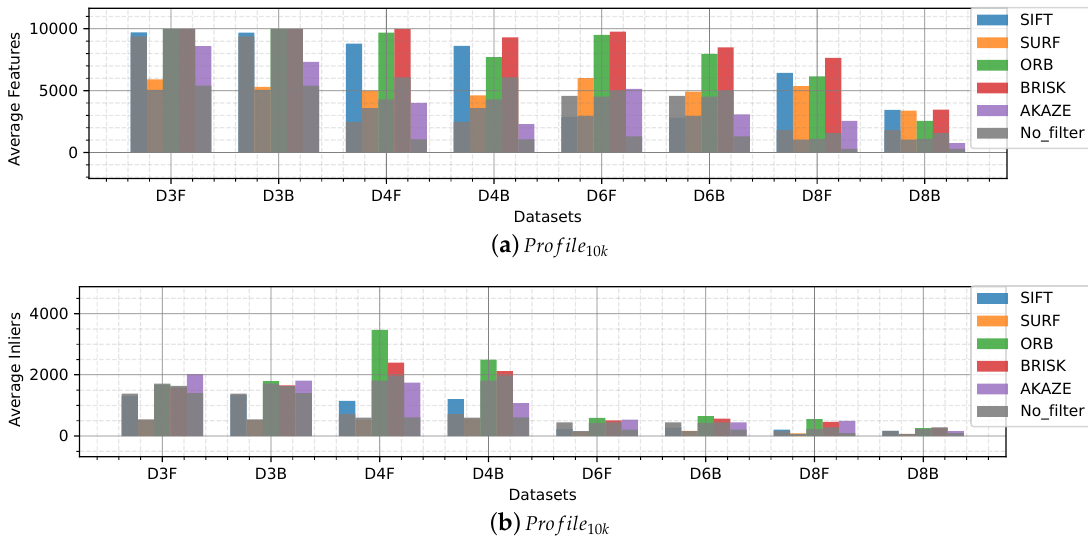
Figure 9. Results for pre-processed Datasets 3, 4, 6 and 8. Labels including an ‘F’ indicates pre-processed